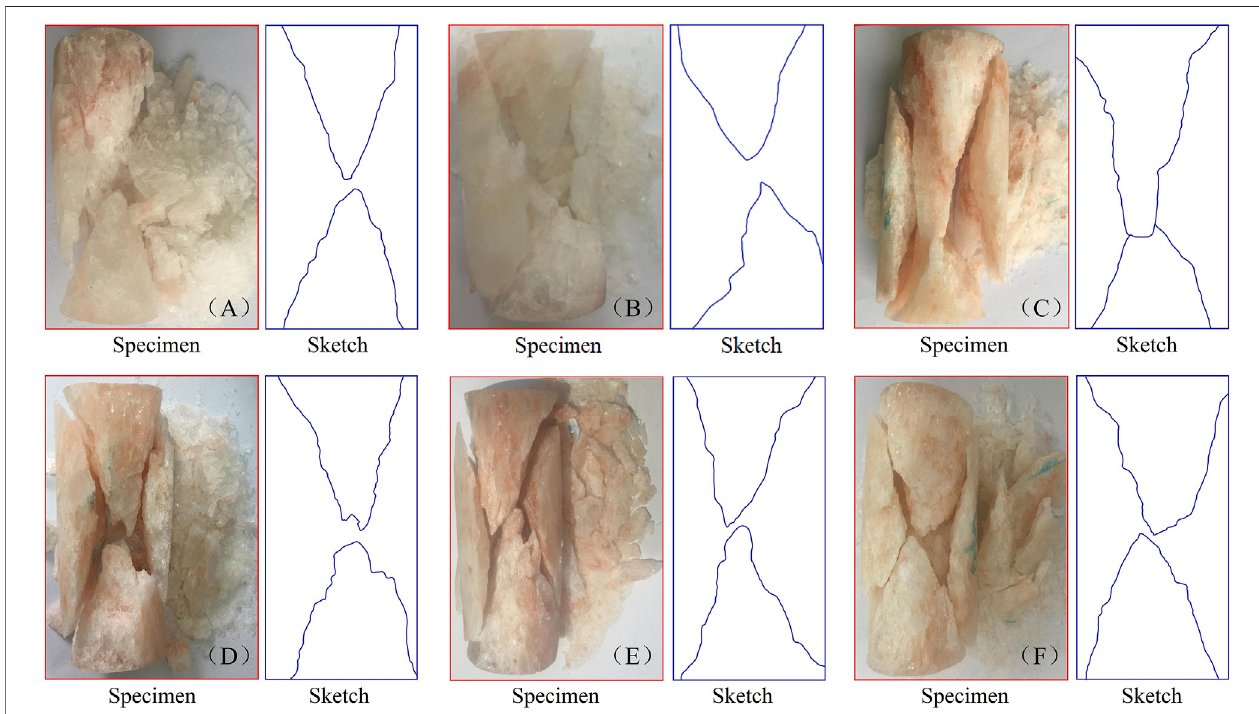
FIGURE3| Macroscopic failure modes ofsalt rock and correspondingsketchmap: (A) u =0.25 MPa · min − 1 , (B) u =1.00 MPa · min − 1 , (C) u =1.50 MPa · min − 1 , (D) u = 2.00 MPa · min − 1 , (E) u = 3.00 MPa · min − 1 , and (F) u = 5.00 MPa · min − 1 (Wang et al.,